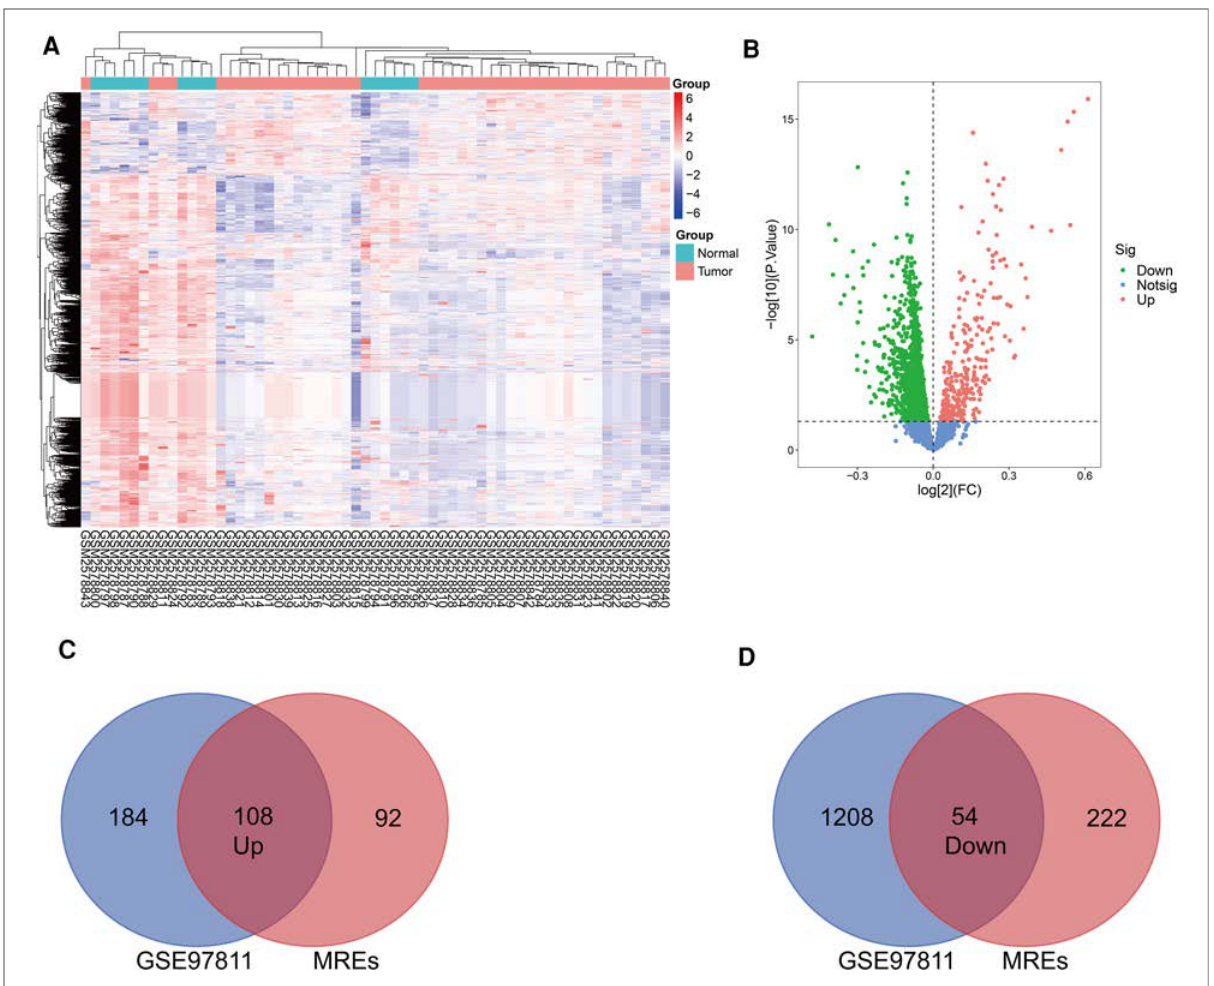
FIGURE 3 Identi fi cation of differentially expressed miRNAs. ( A ) Heatmap of the DE miRNAs from the GEOmicroarray in GSE97811. ( B ) Volcano map for all miRNAs in GSE97811. ( C,D ) Overlap between circRNA-related target miRNAs predicted bythe online tool and DEmiRNAs in